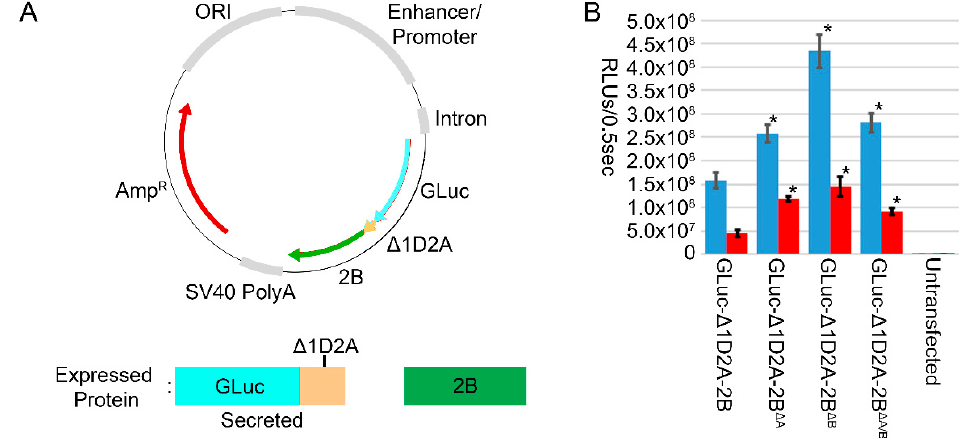
Figure 1. ( A ) The GLuc- Δ 1D2A reporter system used to evaluate 2B effects on transgene expression. The plasmid encoded GLuc- Δ 1D2A and 2B are expressed as a single polypeptide, upon translation ribosome skipping was induced resulting in separate expression of GLuc- Δ 1D2A and 2B. The GLuc- Δ 1D2A was secreted into the media where it was quantified in relative luciferase units per half second (RLUs/0.5 s). ( B ) Luciferase activity for GLuc-2A-2B constructs with and without viroporin- disrupting mutations, in transfected cell cultures: HEK293-T (blue) and CHO-K1 (red). * denotes a significant difference, p < 0.001 as determined by Student’s T-test, between expression of wildtype 2B and viroporin mutants.